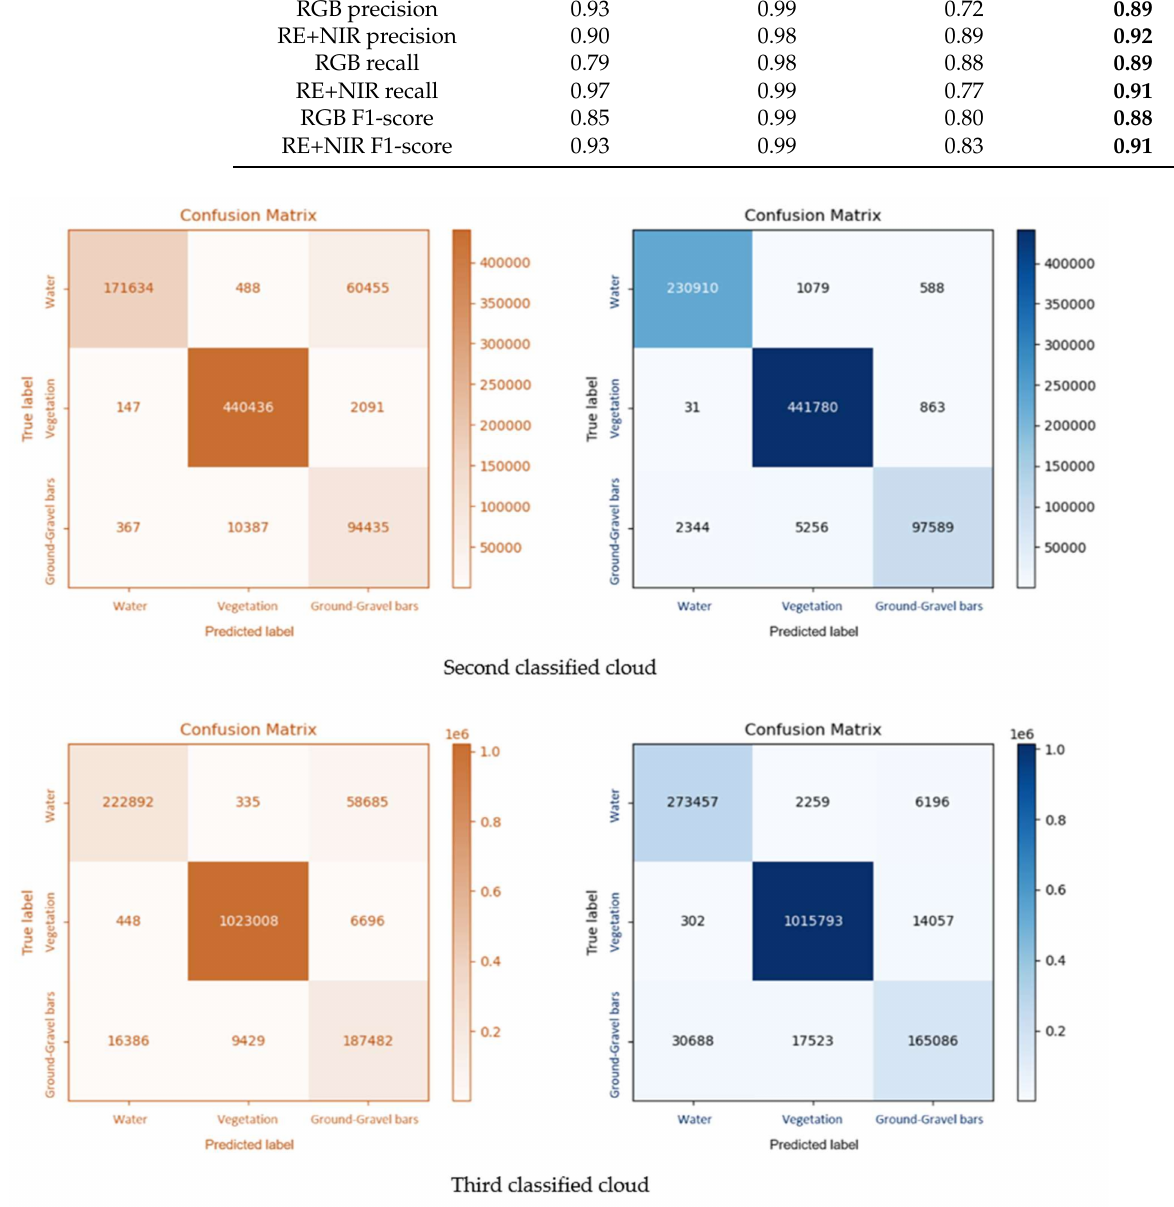
Figure 9. Confusion matrixes obtained about second and third testing classified clouds, respectively. In orange are reported the RGB confusion matrix graphs; in blue are the RE+NIR